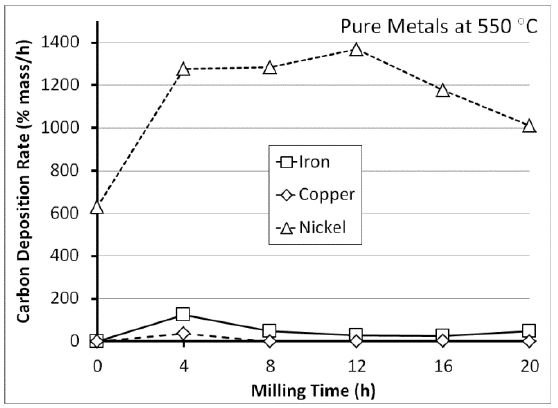
Figure 7. Carbon deposition rates catalyzed by Fe 30 at% Cu milled for ( a ) varying durations and ( b ) at varying temperatures. Samples “milled” for 0 h are the constituent powders blended in the appropriate ratio with no alloying conducted.